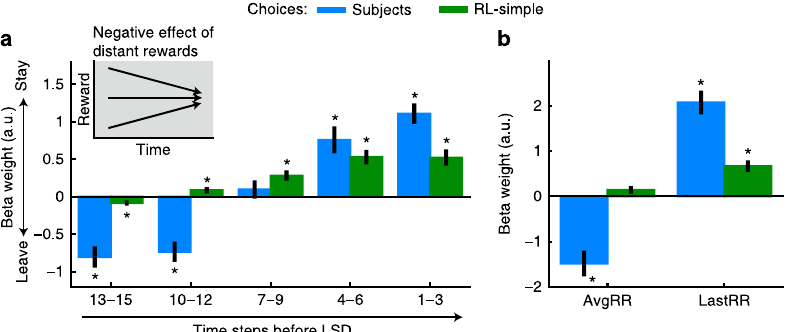
Figure 4. The weights assigned to the past reward experiences on the patch leaving decision in the study by Wittman et al. ( a ) The influences of the past rewarding events occurring in each past time periods on patch leaving decision. The x -axis indicates the past time periods (1–3, 4–6, 7–9, 10–12, 13–15: the lower numbers mean the proximity to the current time). The y -axis shows the weights on the patch leaving decision: positive values signifies influences for staying in the current environment and the negative values means the influences for leaving the current patch. Blue bars are the weights calculated from actual data of the subjects. The green bars are the weights calculated from the simulated data generated by the simple reinforcement learning (RL) model fitted to the actual subjects’ data. ( b ) The weights calculated for the short-term and the long-term reward rates on the patch leaving decision. The long-term (average) reward rates act to bias decisions for leaving the current environment and the short-term (last) reward rates influences decision for staying in the current patch (Image adapted with permission from Wittmann et al., Nature Communications, 2016; Nature Publishing Group [66]).